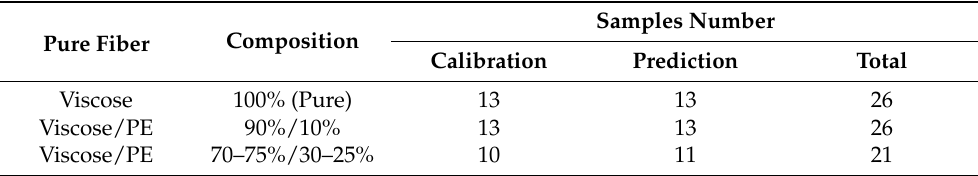
Table 4. Study #2: Pure viscose and viscose/PE mixtures. Pure